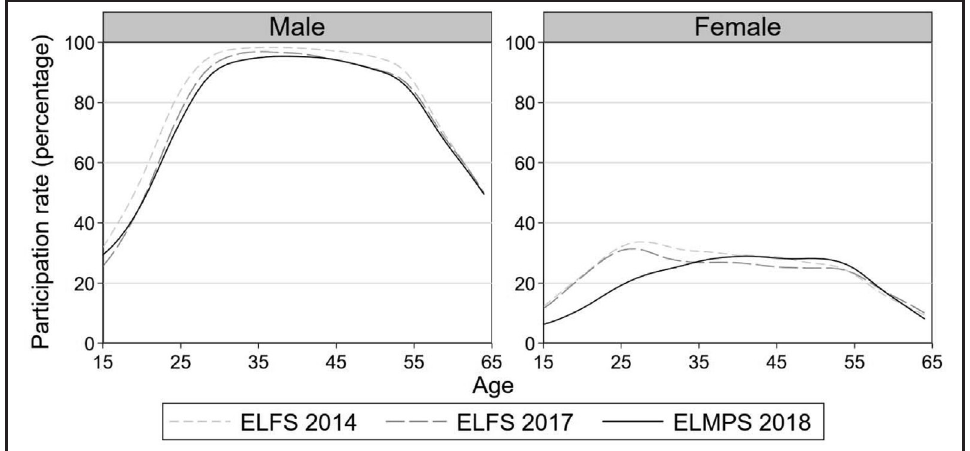
Labor force participation rates (percentage) by sex, age, and data source.